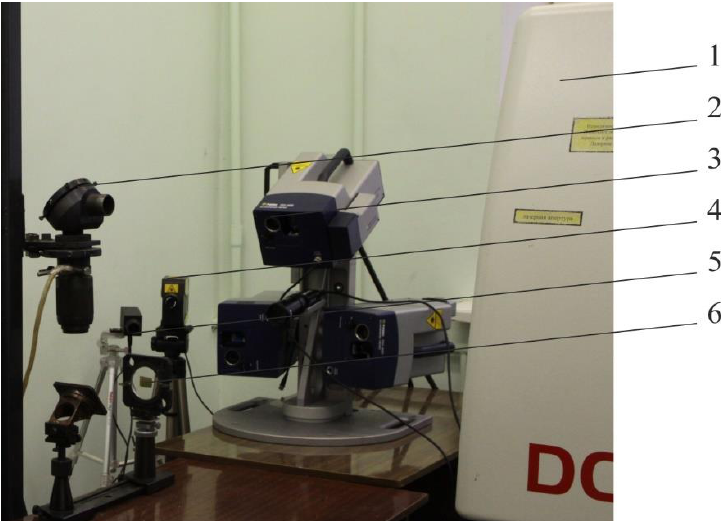
Figure 1. Photo of an experimental setup for samples processing and study of vibrational characteristics of objects during the formation of arrays of zinc oxide nano-objects: 1—ROFIN DC 010 radio frequency excited and diffusion-cooled CO 2 laser ; 2—a mirror of the optical system; 3—Polytec PSV-400-3D three-axis scanning laser vibrometer; 4—Polytec PDV 100 two-coordinate measuring device (Polytec GmbH, Waldbronn, Germany); 5—Kelvin LCM-1300M non-contact thermometer (Astena, Ryazan, Russia); 6—sample from brass L62.